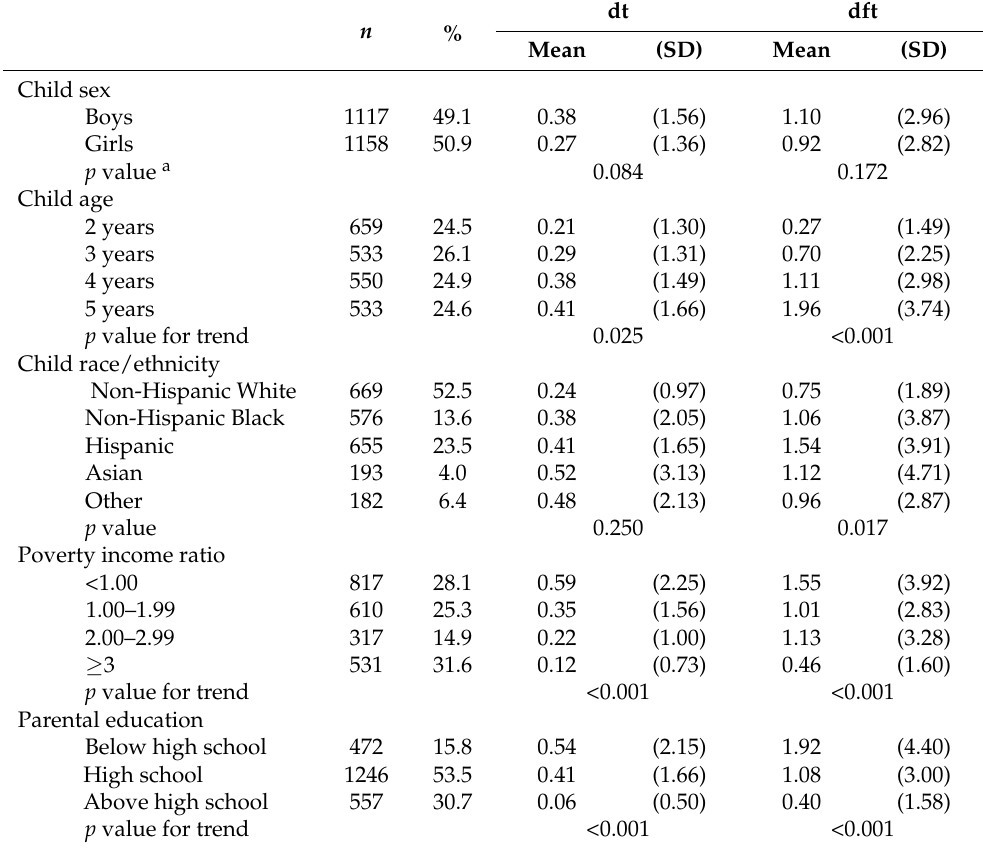
Table 1. Description of the study sample and comparison of dental caries indicators by